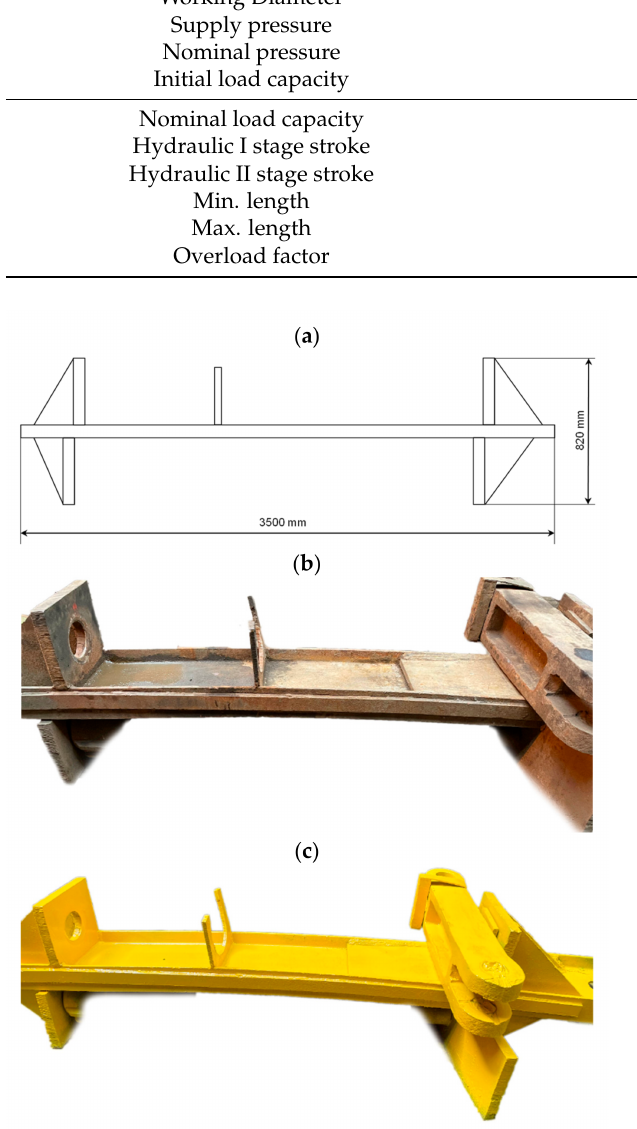
Figure 6. Test site, where ( a ) draft position, ( b ) during construction, and ( c ) finished